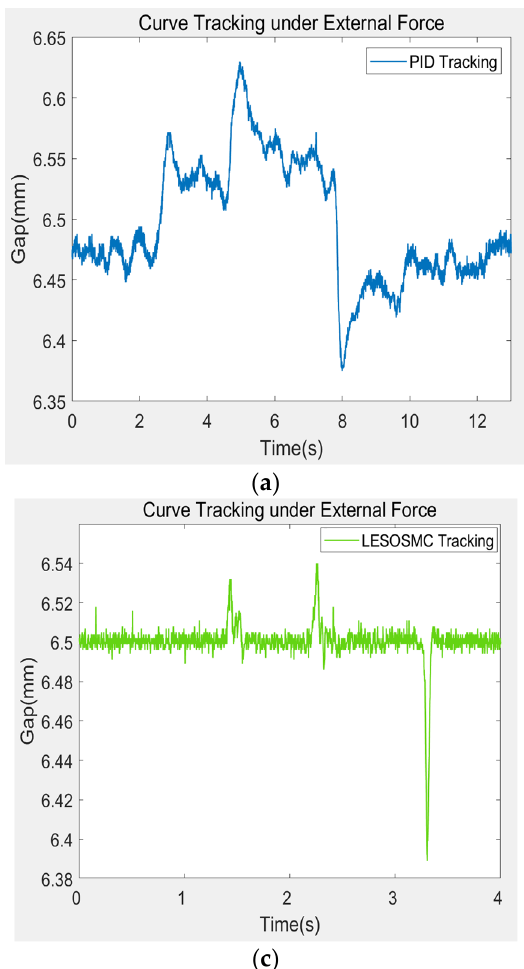
Figure 23. Curve tracking chart controlled by different algorithms under external force: ( a ) PID algorithm; ( b ) SMC algorithm; ( c ) LESOSMC algorithm.